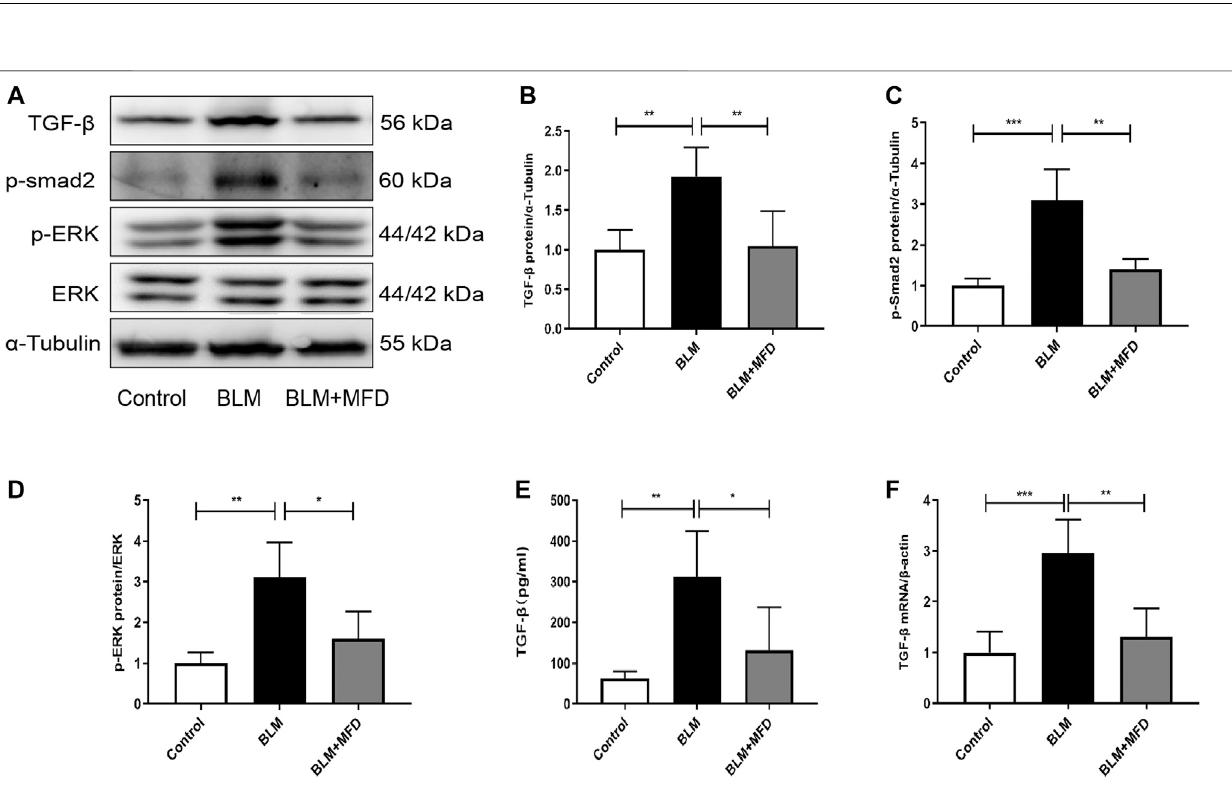
FIGURE 4 | Mefunidone suppressed TGF- β /Smad2 and MAPK pathways (A-D) : Western blotting (A) and quantitative analysis of TGF- β (B) , p -Smad2 (C) and p -ERK (D) in mice lung tissues (E) : The TGF- β concentration in BALFs of mice (F) : The mRNA levels of TGF- β in lung tissues ofmice. All data were presented as mean ± SD. ANOVA was used for comparison in (B-D). * p < 0.05; ** p < 0.01; *** p < 0.001.